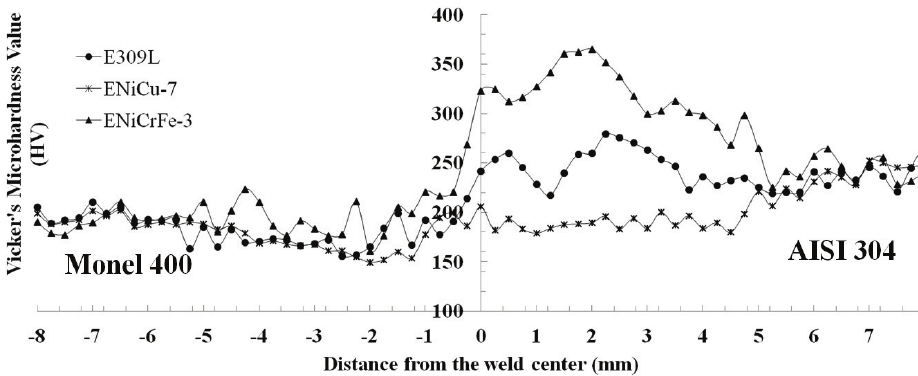
Figure 4. Hardness profile of the PCGTAW dissimilar combinations of Monel 400 and AOSO 304.